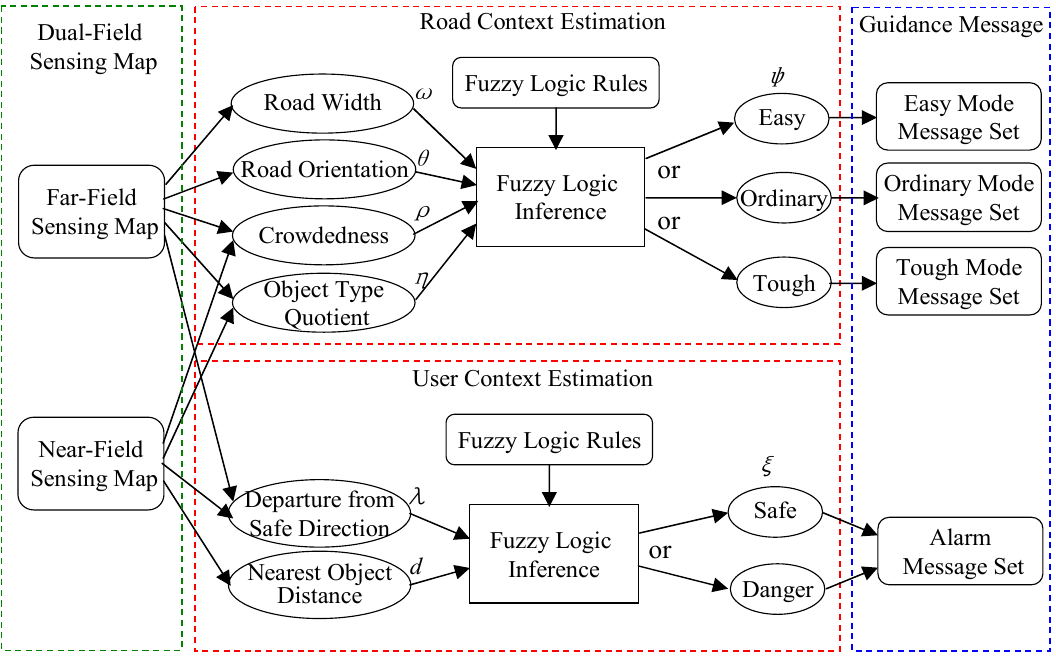
Figure 15. Walking context estimation based on dual-field sensing.